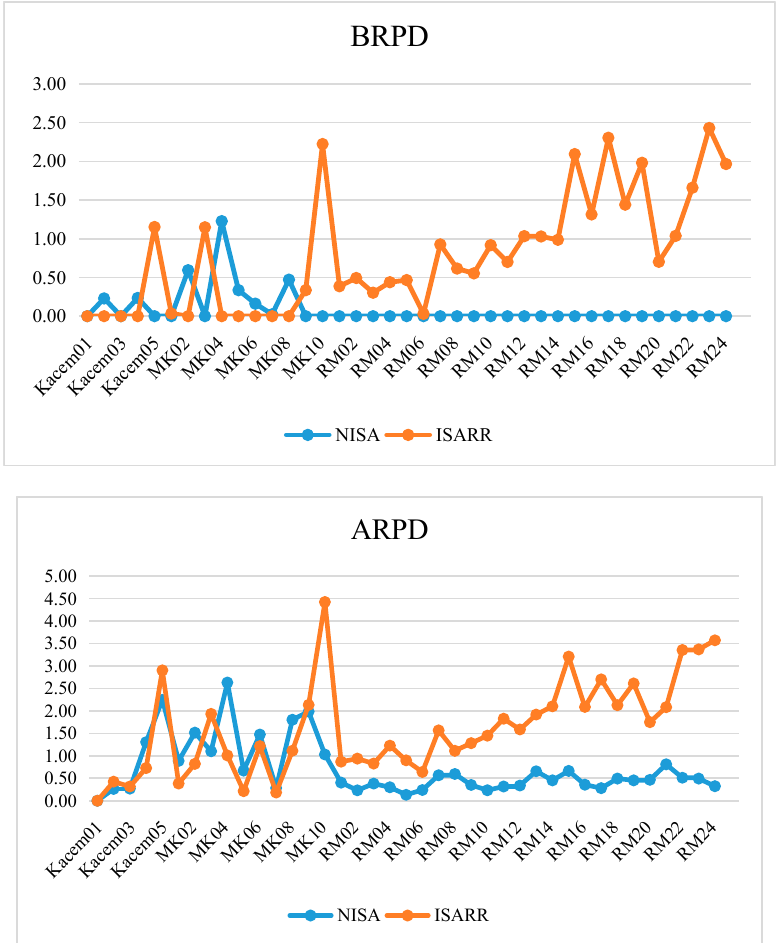
Figure 4. The curves of BRPD and ARPD in the comparison between NISA and ISARR. Table 4. Effectiveness analysis of the population initialization approach.